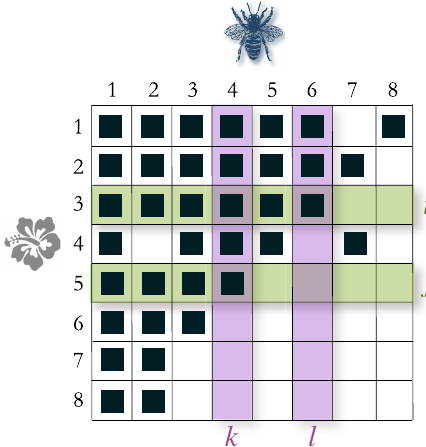
FIG. 3. Example of an ordered matrix of interactions not perfectly nested. Species of both guilds are ordered in decreasing degree, and the numbered labels indicate their rank (the larger the degree, the smaller the rank). The indexes i , j , k , and l illustrate our notation for rows and